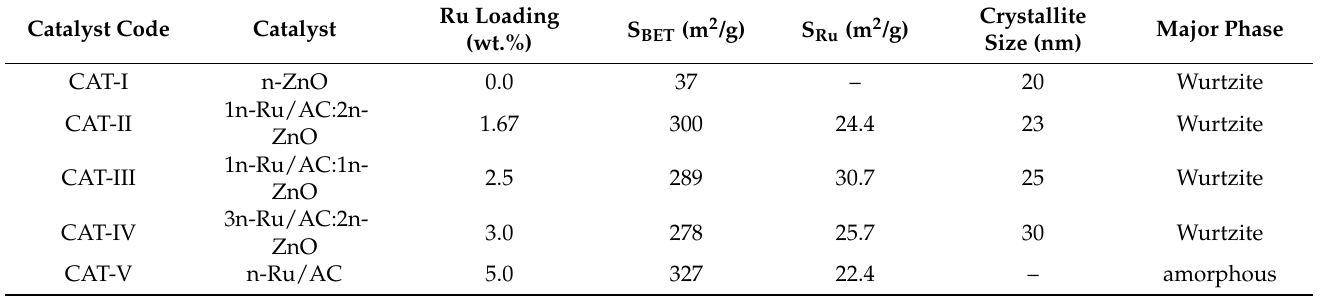
Table 1. Textural properties and characteristics of investigated catalysts [6].